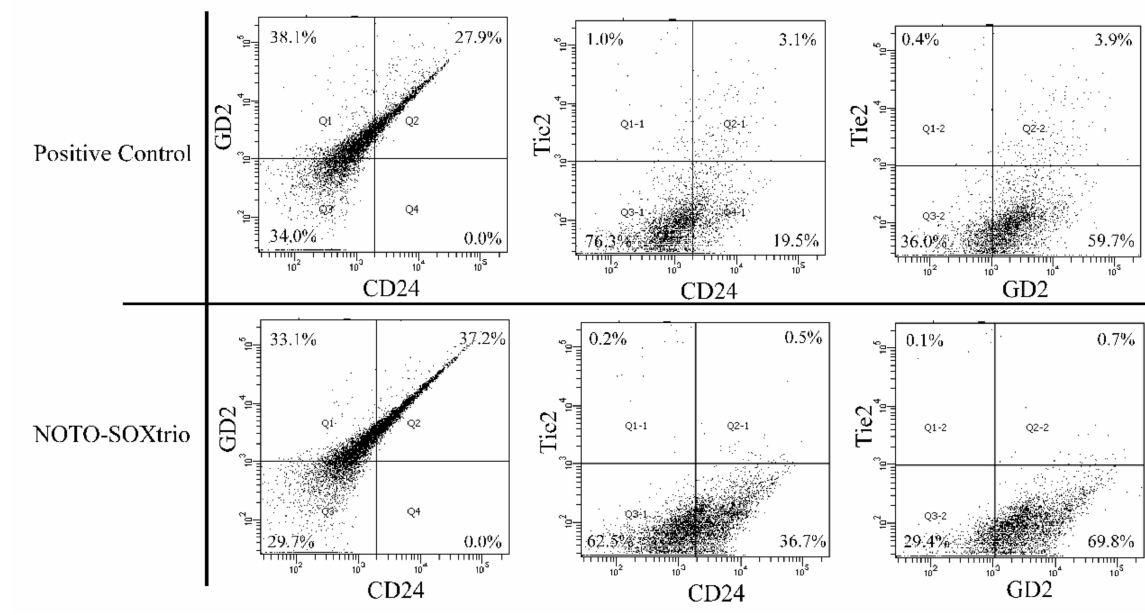
Figure 6. FACS analysis of NP-like